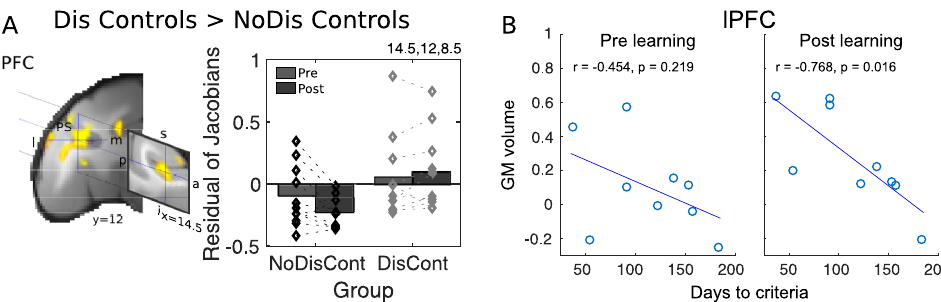
Fig 3. (A) lPFC GM volume is greater in control animals who experienced discrimination learning (Dis Cont) relative to control animals who had learning experience (NoDis Cont) between scan 1 and scan 2. (B) lPFC GM volume before (left panel) and after (right panel) DisRev learning training (DisRev learners) correlated with the number of training days the animals required to reach performance criterion. The negative relationship between lPFC GM volume and performance, although evident before learning, only becomes significant after extended experience of DisRevs. a, anterior; Dis Cont, discrimination control; DisRev, discrimination reversal; GM, gray matter; I, inferior; l, lateral; lPFC, lateral prefrontal cortex; m, medial; NoDis Cont, no-discrimination control; p, posterior; PS, principle sulcus; s, superior. Data are available on https://www.jeromesallet.org/data-ofc-reversal-learning and https://doi.org/10.5281/